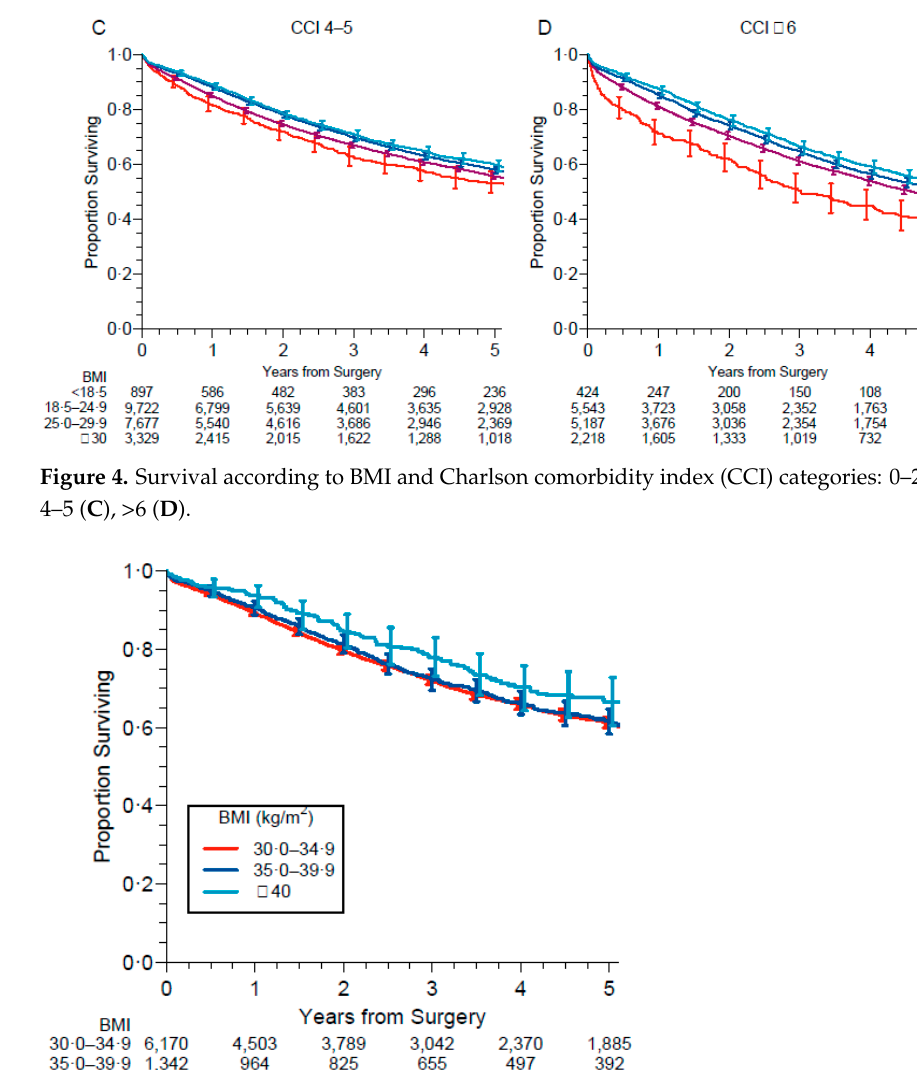
Figure 6. Survival according to obesity categories in different histologic types: ( A ) Adenocarcinoma, ( B )Squamous-Cell Carcinoma; ( C ) Small-cell carcinoma; ( D ) Carcinoid tumors (typical and atypi- cal); ( E ) Others. Obesity classes are defined as class 1: BMI 30.0–34.9, class 2: BMI 35.0–39.9 and class 3: BMI ≥ 40.0. 4. Discussion In the present study, we report evidence that BMI is a strong predictor of survival in patients undergoing radical surgery for NSCLC; underweight was associated with a worse prognosis, whereas overweight and, to a greater extent, obesity with a better prog- nosis. In particular, severe obesity is associated with an even better outcome. This impact of BMI on long-term survival mirrors the effect on perioperative outcome previously re- ported in resectable lung cancer [15]. We also show that the prognostic significance of obesity is independent from the “classical” prognostic factors of resectable lung cancer, namely pathologic stage, histo- logic type, extent of resection, sex, age, PS, or CCI [20,21], and the prognostic value of